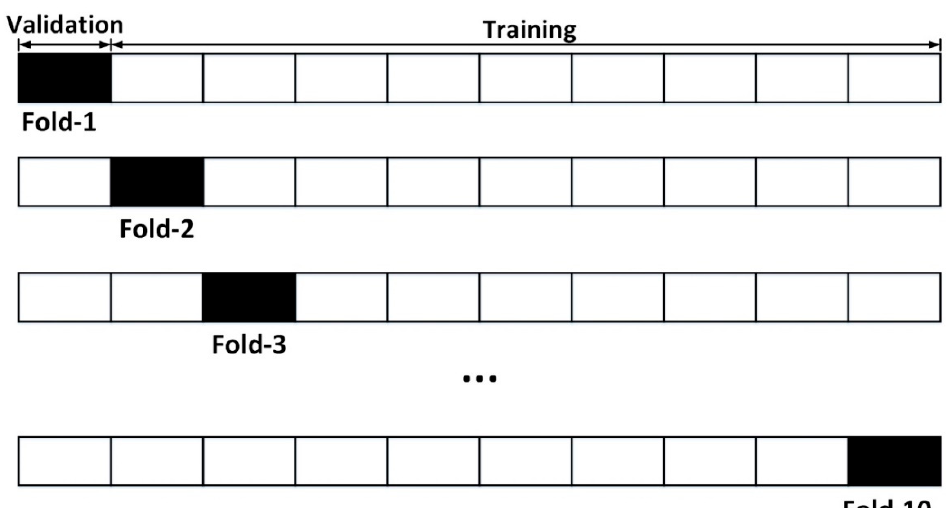
Figure 6. The principle of the 10-fold cross-validation. The dataset is divided into 10 parts, of which nine are used for training and one for validation. The subset that is used for validation is different in each of the 10 repeated model fittings and validations.